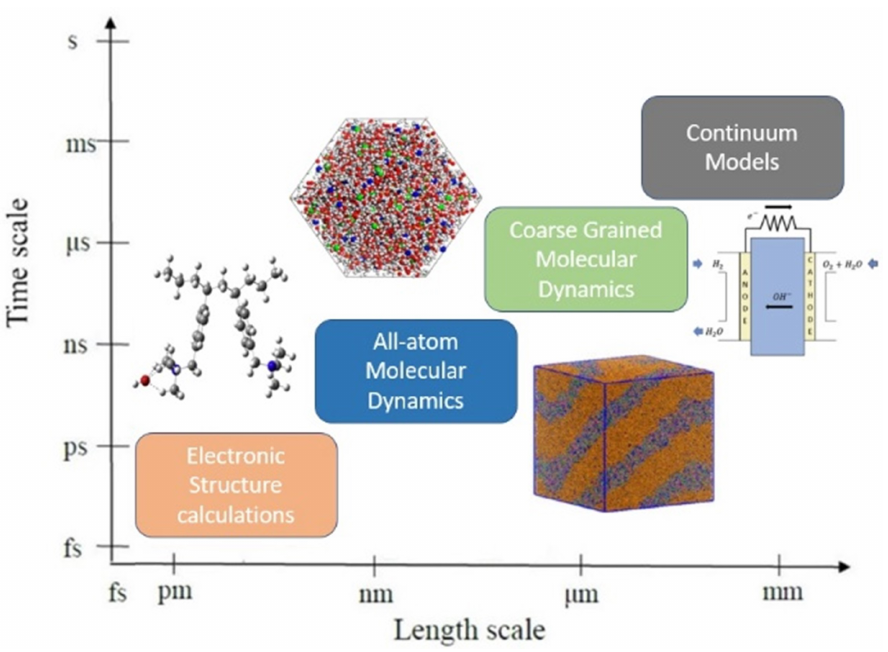
Figure 3. The level of hierarchy from the atomic scale to the system level. Reprinted with permission from [50–53]. Copyright 2016, for Elsevier [50], copyright 2017, for the American Chemical Soci- ety [51], copyright 2014, for the American Chemical Society [52], and copyright 2017, for Elsevier